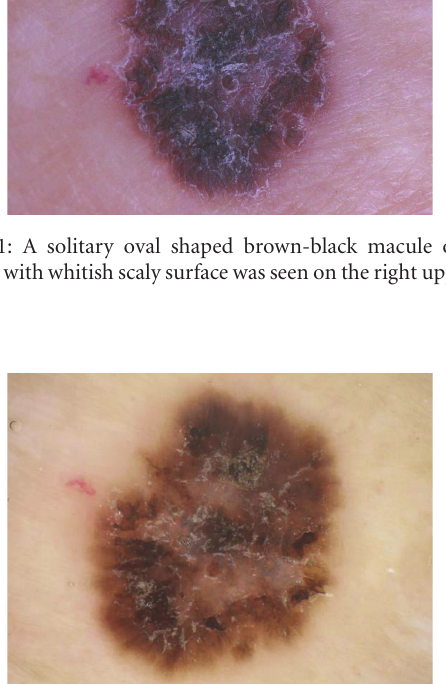
Figure 2: Dermoscopic examination demonstrated irregular flossy streaks, irregular brown dots/globules, and blue-whitish regression structures with overlying whitish scaly areas.